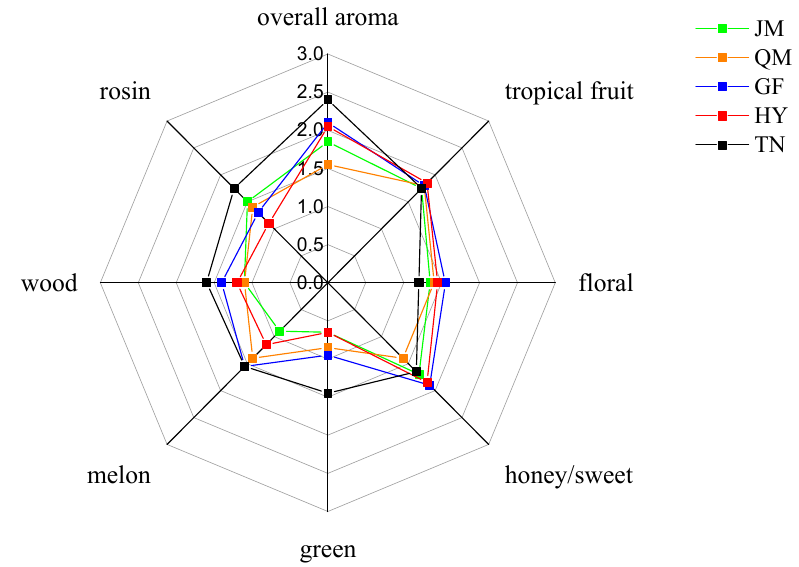
Figure 1. Spider plot for flavor attributes of five varieties mango samples. Jinmang—JM, Qingmang— QM, Hongyu—HY, Guifei—GF, and